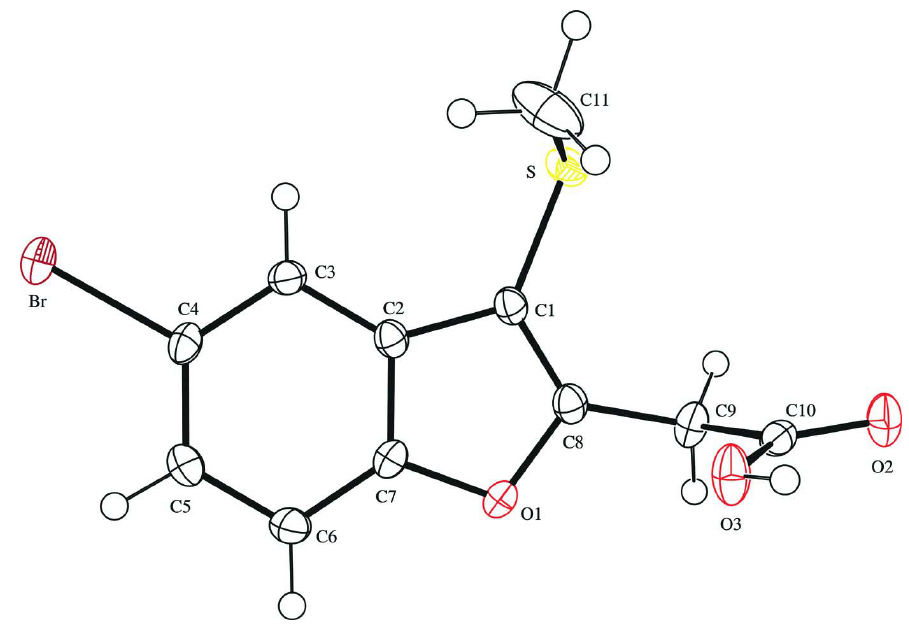
Figure 1 The molecular structure of the title compound, showing displacement ellipsoids drawn at the 50% probability